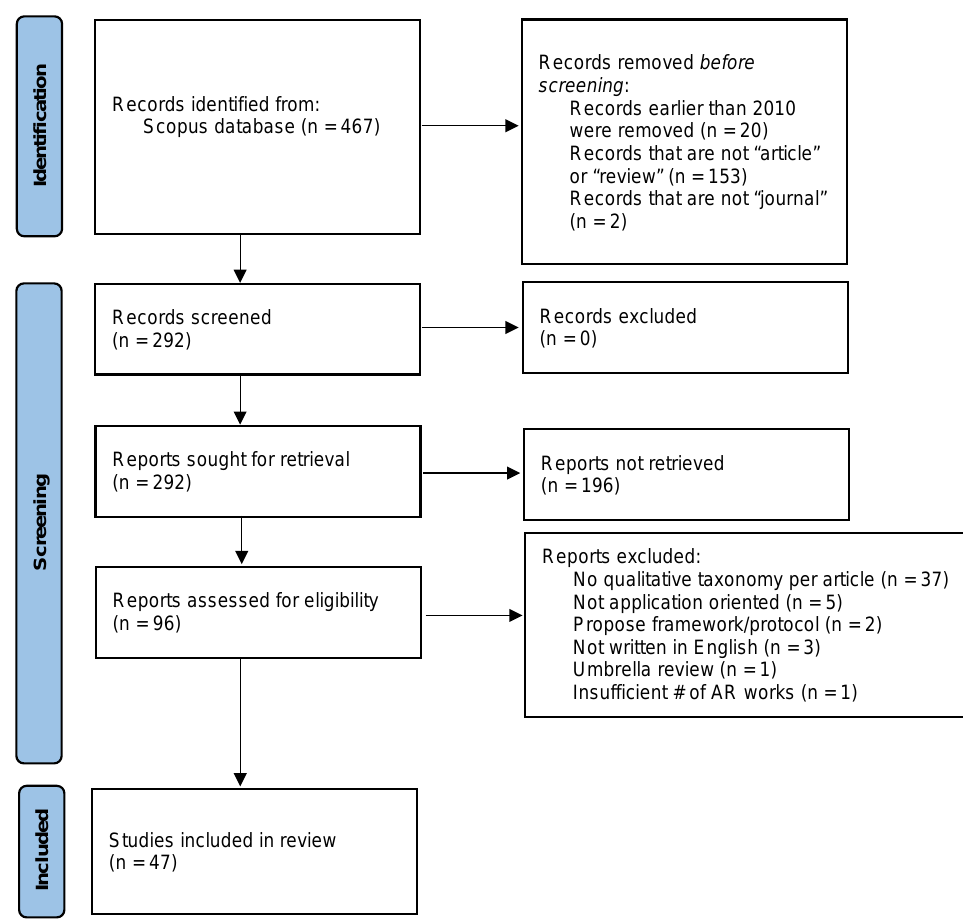
Figure 3. Flow diagram of the article selection process (initially: 467, finally